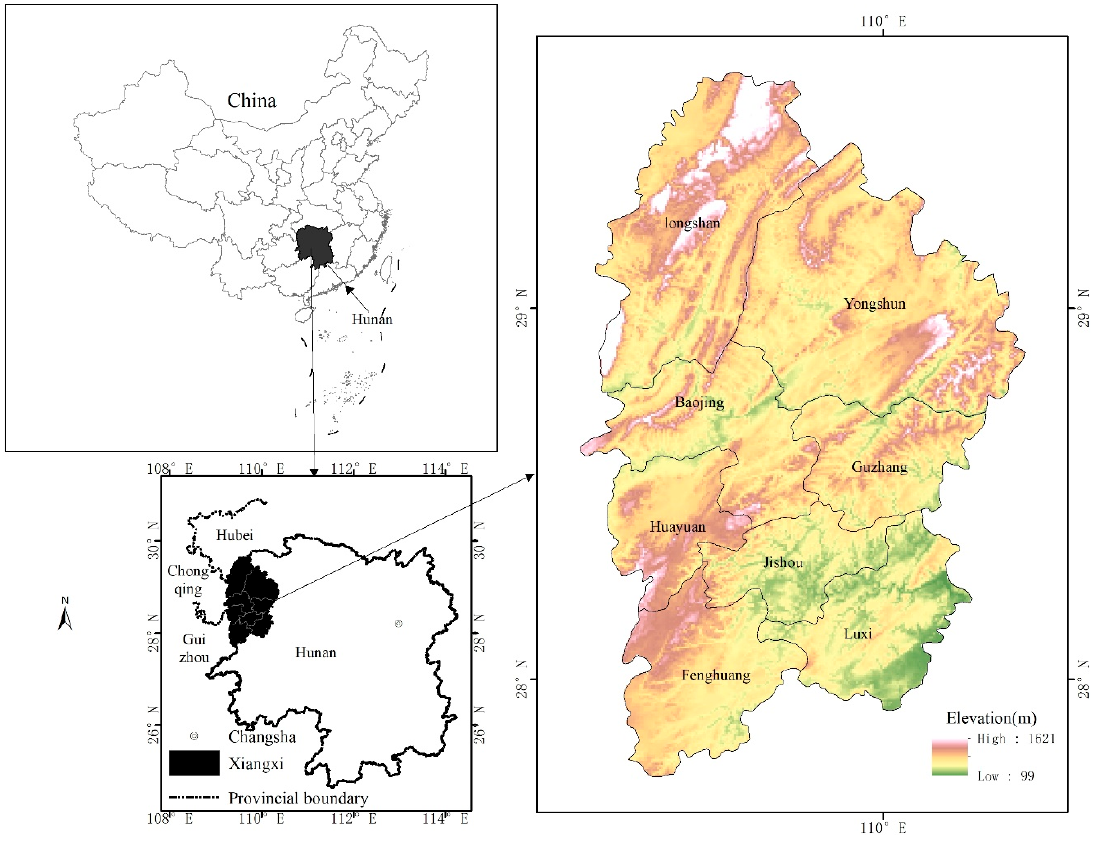
Figure 1. Map of the study area.